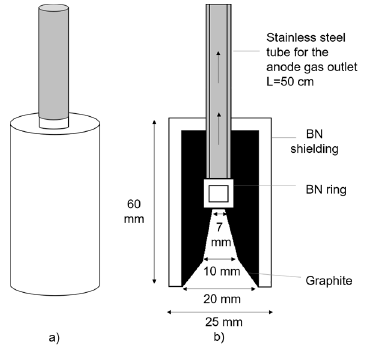
Figure 3. The hollow gas anode; ( a ) the outer body of the hollow gas anode, ( b ) cross-section of the hollow anode design with the inverted funnel shape, anode surface area approx. 10.8 cm 2 .